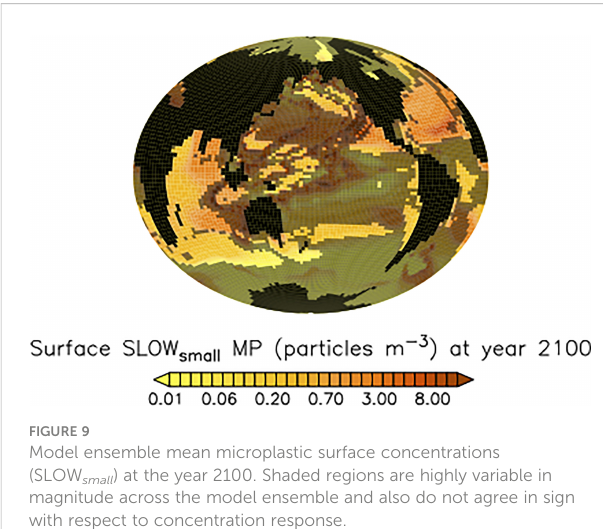
FIGURE 9 Model ensemble mean microplastic surface concentrations (SLOW small ) at the year 2100. Shaded regions are highly variable in magnitude across the model ensemble and also do not agree in sign with respect to concentration response. FIGURE